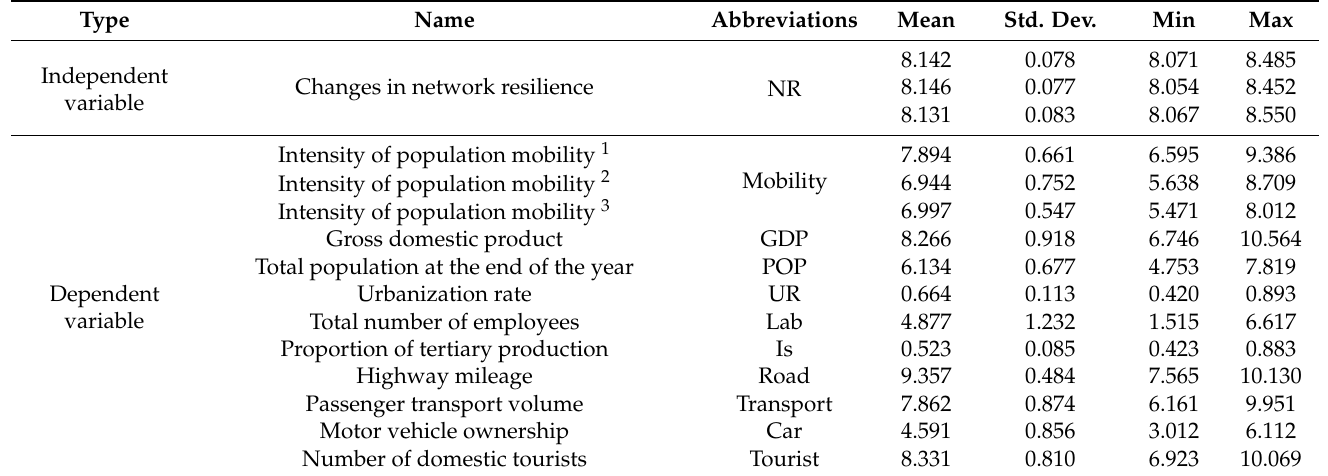
Table 2. Variable selection and descriptive